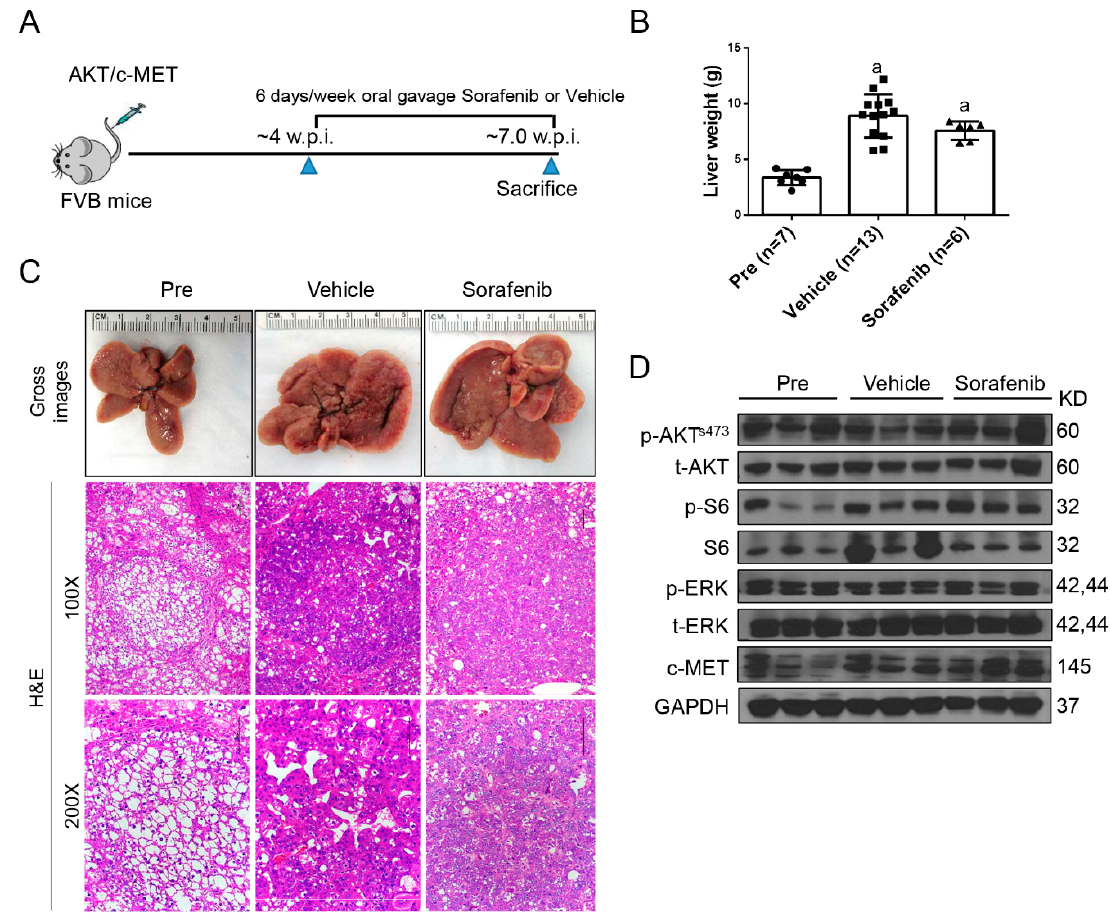
Figure 1. Effect of sorafenib treatment in AKT/c-MET mice. ( A ) Study design. ( B ) Liver weight of pre-treatment, vehicle-, and sorafenib-treated AKT/c-MET mice. ( C ) Gross images and H&E staining of livers from pre-treatment, vehicle-, and sorafenib-treated AKT/c-MET mice. At the pre-treatment stage (Pre), livers of AKT/c-MET mice appear occupied by clear-cell, lipogenic tumors, which are subsequently (vehicle and sorafenib treated groups) substituted by more basophilic lesions. ( D ) Effect of sorafenib administration on the levels of putative target proteins in livers from AKT/c-MET mice. (Magnifications: 100 × and 200 × , Scale bar: 100 µ m). Abbreviations: H&E, hematoxylin and eosin staining; Pre,